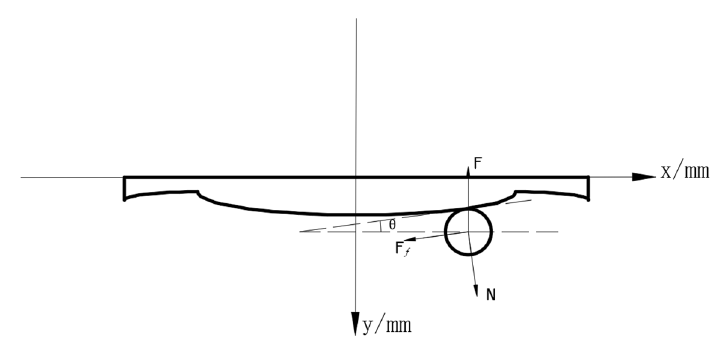
Figure 2. Motion state of negative-stiffness device. ( a ) Initial state of the device ( b ) Device state after horizontal displacement, u.